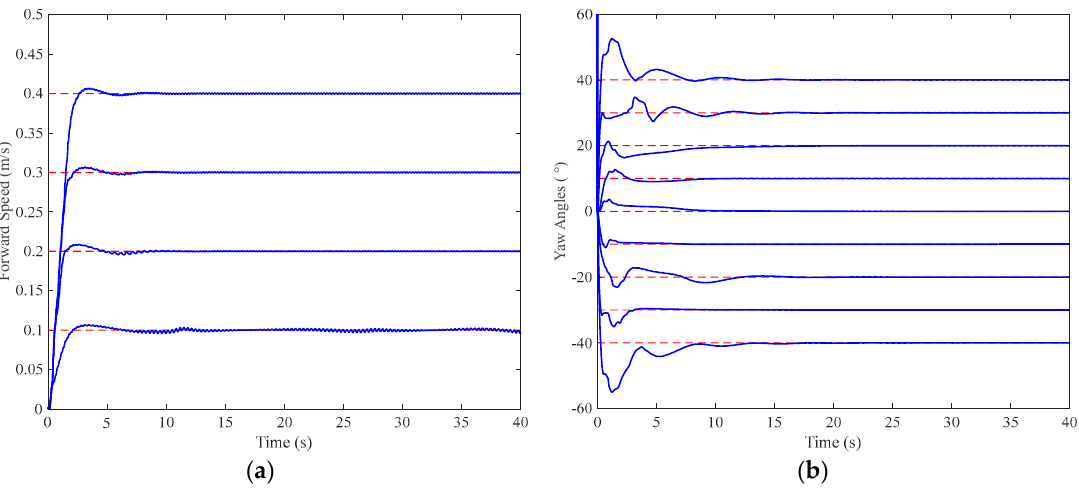
Figure 17. Closed loop responses of the 6-DoF system during 40 s simulation time: ( a ) Forward speed control; ( b ) Yaw angles tracking control.